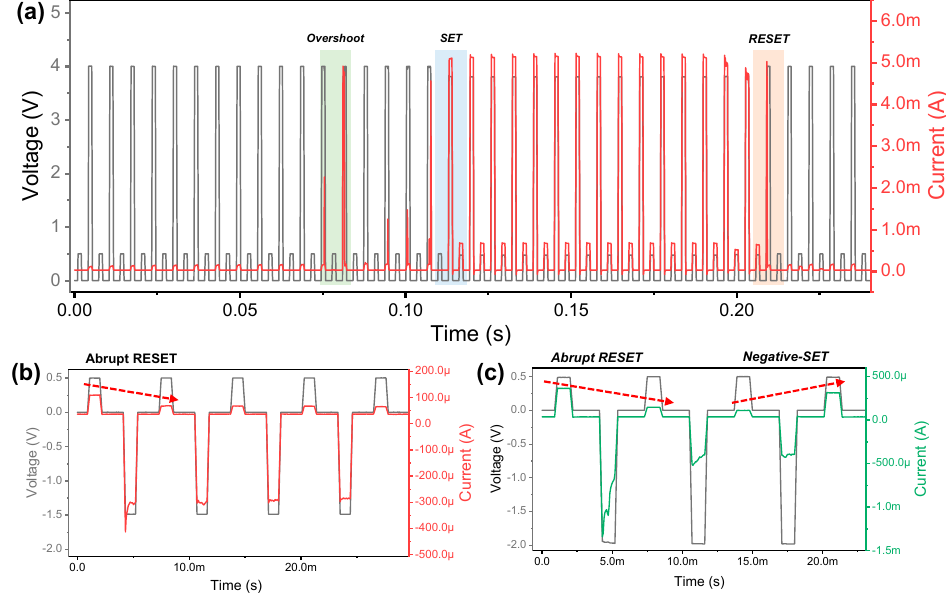
Figure 3. Resistive switching dynamics by pulses, including program/erase and read for Ag/ZrN/Si device. ( a ) Abrupt reset process after abrupt set process by positive voltage pulses. ( b ) Abrupt reset process by negative voltage pulses. ( c ) Negative-SET behavior after gradual reset process.